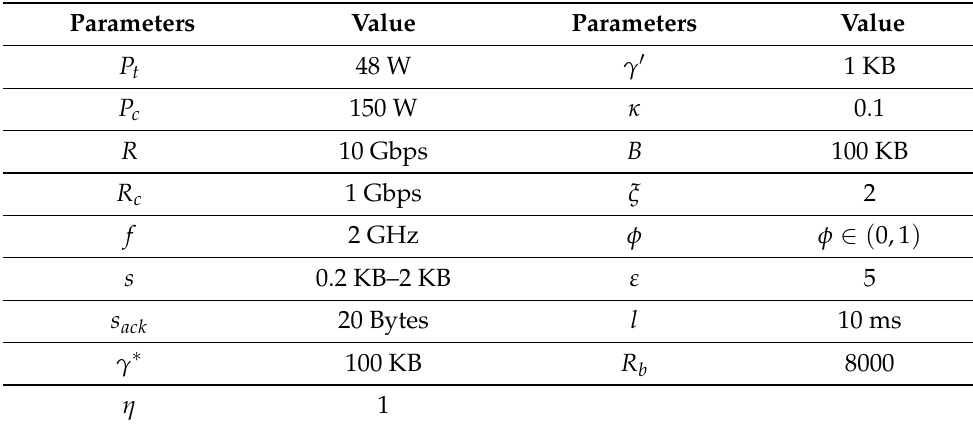
Table 2. Parameters and